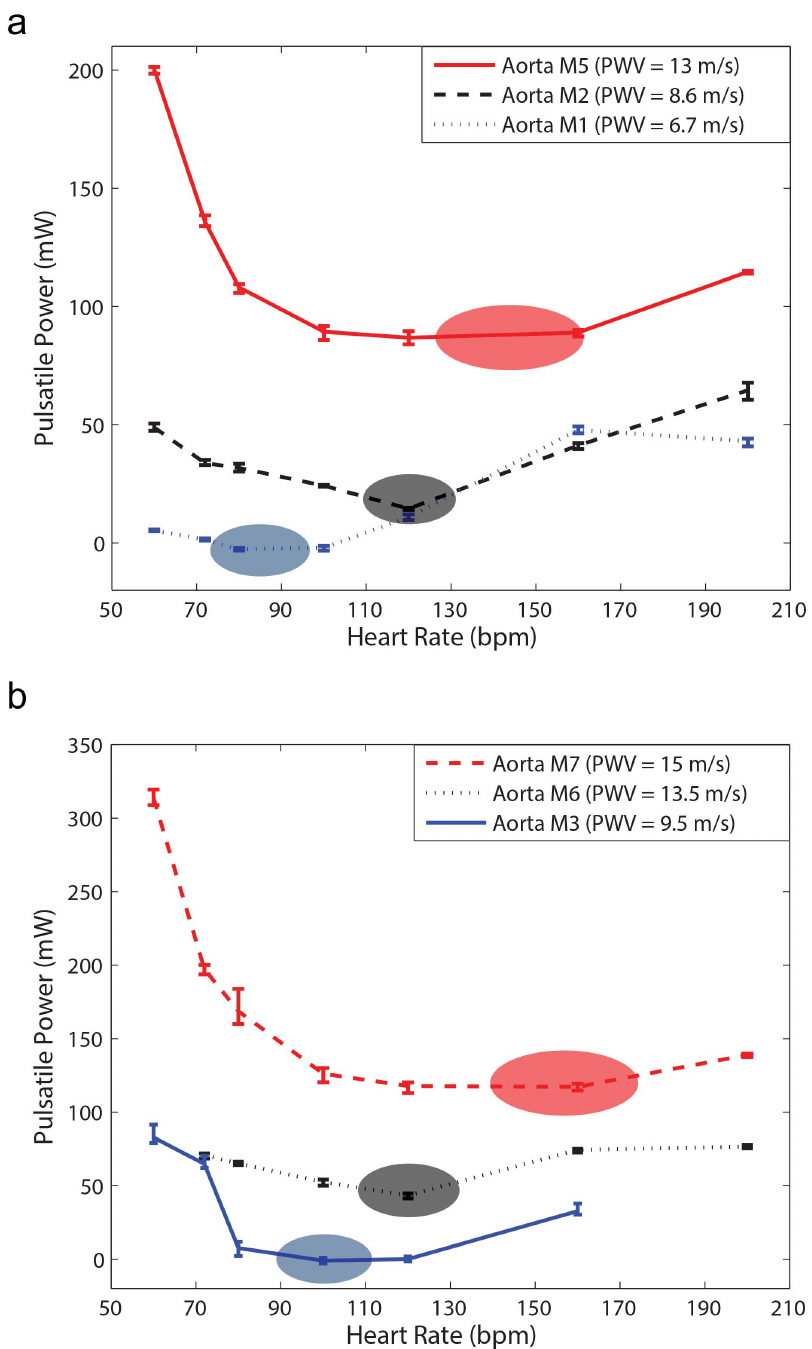
Figure 6. Pulsatile power versus heart rate (HR). a) Results of Setup2 (low TC condition) for three different aortic rigidities; CO=5 L/min for all data points (please see supplementary data file for all other aortas). b) Results of Setup1 (high TC condition) for three different aortic rigidities; CO=5 L/min for all data points (please see supplementary data file for all other aortas). There is an optimum HR in which pulsatile power is minimized. As the aortic rigidity increases, the optimum HR shifts to a higher value. Pulse wave velocity ( PWV ) is the wave speed and it is an index for aortic rigidity. Each power data point is the result of the respective experiment repeated five times.